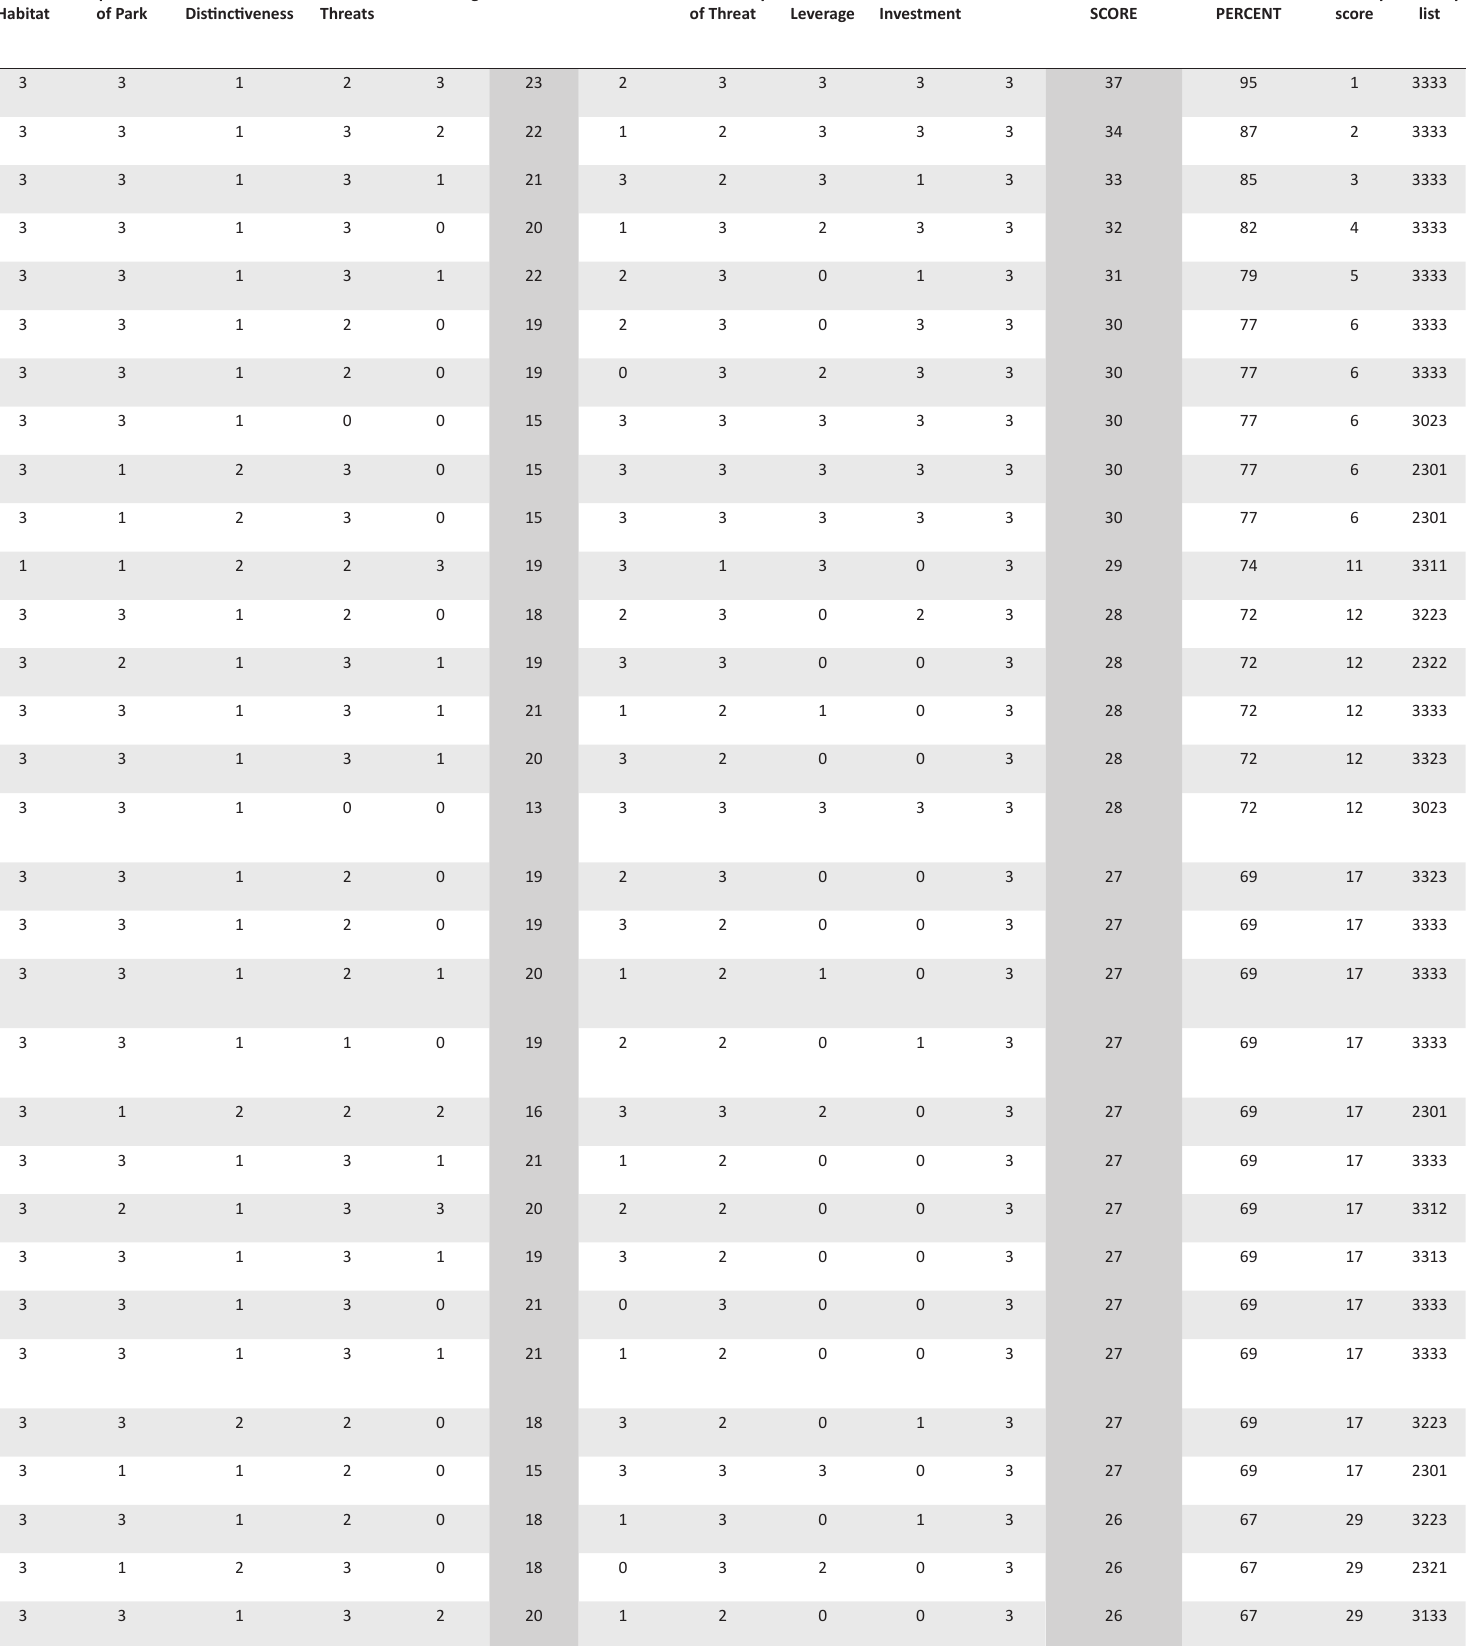
Online Appendix Table 1: List of species of Special Concern in the Table Mountain National Park and associated scores Species